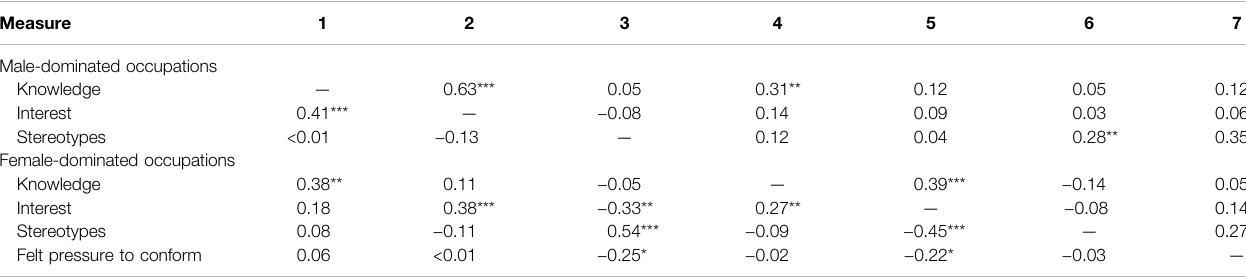
TABLE 1 | Bivariate correlations among measures for boys and